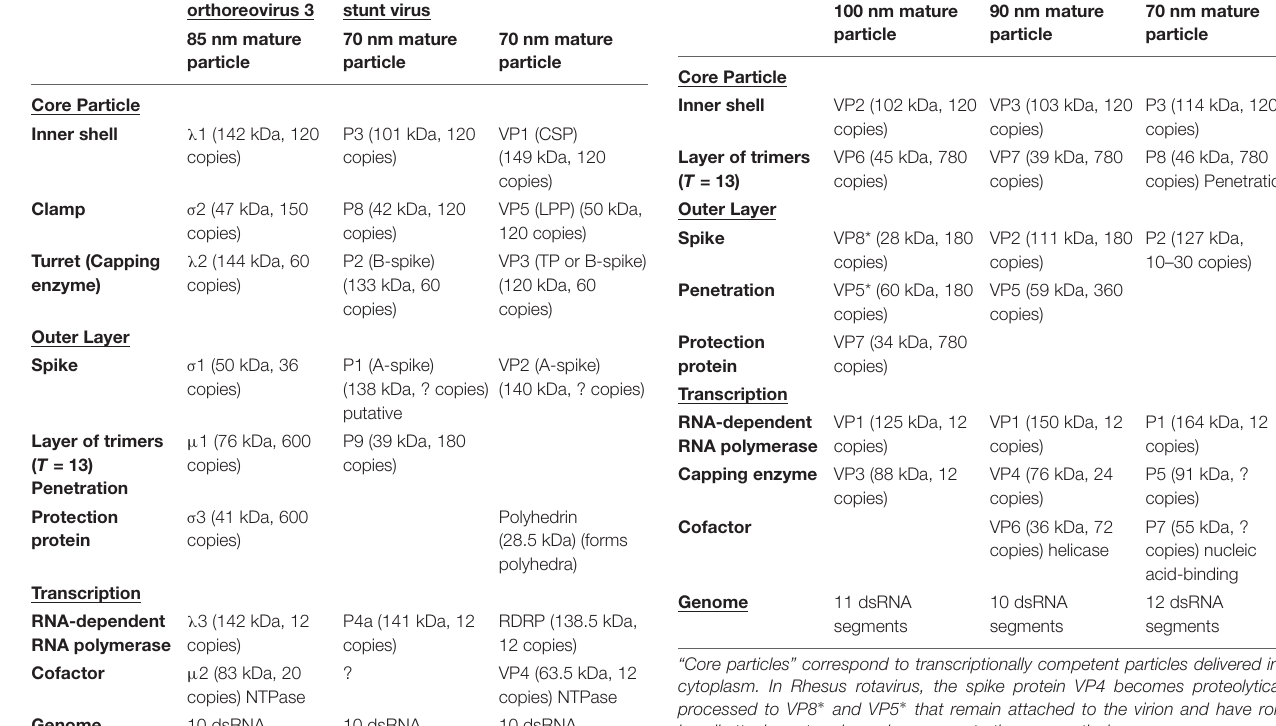
TABLE 3 | Protein and nucleic acid composition of virions of the non-turreted Sedoreovirinae subfamily and representative for the genera Rotavirus (Rhesus rotavirus: Pesavento et al., 2006; Guglielmi et al., 2010; Arias et al., 2015), Orbivirus (Bluetongue virus; Mertens and Diprose, 2004; Mohl and Roy, 2014; Roy, 2017), and Phytoreovirus (Rice dwarf virus: Lu et al., 1998; Hagiwara et al., 2003; Nakagawa et al., 2003). Rhesus rotavirus Bluetongue virus Rice dwarf